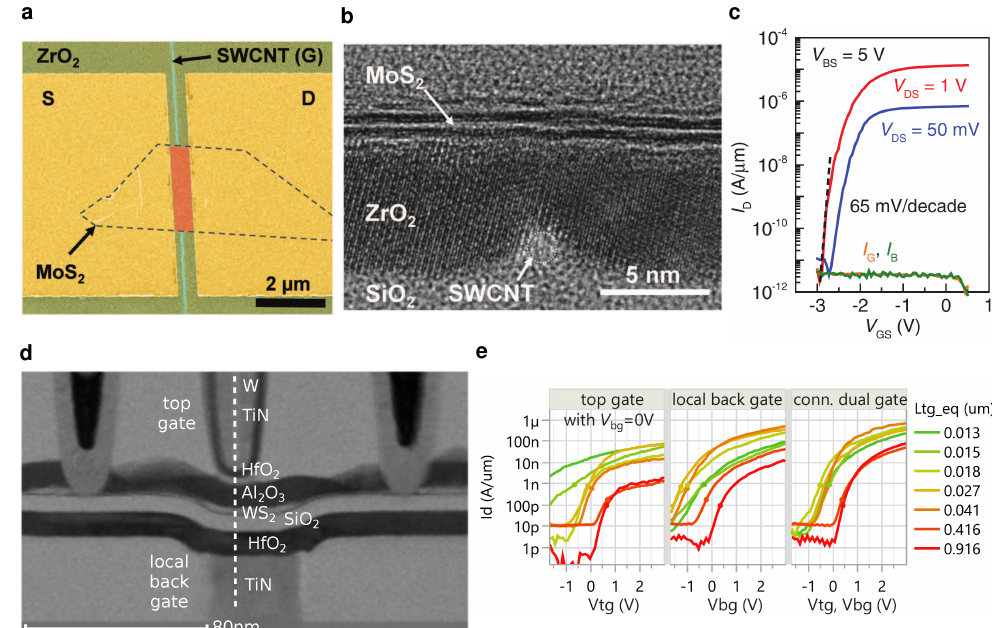
Figure 2. ( a ) False–colored scanning electron microscopy image of a MoS 2 FET with a channel length of 1nm. The MoS 2 flake (in orange) is gated by a single walled carbon nanotube (SWCNT, in cyan), contacted by Ni source and drain electrodes (in yellow), using ZrO 2 as a gate insulator (in green). ( b ) Cross-sectional TEM of the MoS 2 /ZrO 2 /SWCNT transistor, where the SWCNT gate, the ZrO 2 insulator and the layered MoS 2 channel can be seen. ( c ) I D - V GS characteristics of the MoS 2 /ZrO 2 /SWCNT FET at a bias of V BS = 5V, which was applied to the global silicon back gate to n-dope the access regions. A steep subthreshold slope of 65mV/dec is achieved. ( a – c ) reproduced with permission from S. Desai et al., Science 354, 96–99, 2016; published by the American Association for the Advancement of Science [34]. ( d ) Cross-sectional TEM of a double-gated WS 2 transistor using few-layer MOCVD deposited WS 2 as a channel and ALD grown HfO 2 as a gate insulator. To the right of the dashed line the materials of the two gate stacks are listed: W-TiN-HfO 2 -Al 2 O 3 -WS 2 -SiO 2 -HfO 2 - TiN-n + Si. In the connected dual gate design, the back gate is connected via the n + well to the top gate. ( e ) Comparison of the I D - V GS characteristics of the HfO 2 /WS 2 /HfO 2 FET for either a